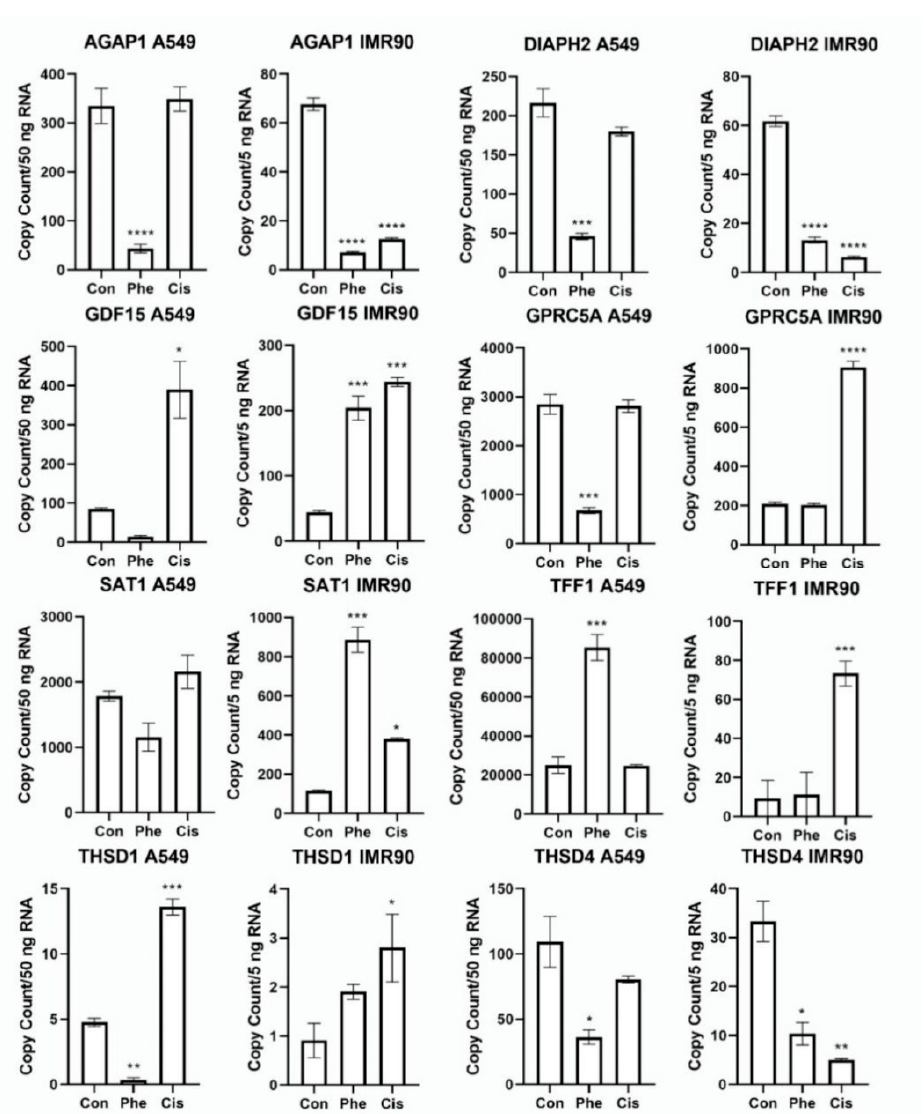
Figure 7. Validation of select regulated genes identified by next generation sequencing using droplet digital polymerase chain reaction in A549 and IMR90 cells. Mean expression of the genes, AGAP1, DIAPH2, GDF15, GPRC5A, SAT1, TFF1, THSD1, THSD4, as measured by ddPCR. Graph labeling: Con = control; Phe = phenanthriplatin; Cis = cisplatin. Y-axis represents copy count for 50 ng RNA sample. Mean ( ± SEM); N = 3; p < 0.05; “*” = p < 0.05; “**” = p < 0.01; “***” = p < 0.001; “****” = p < 0.0001.